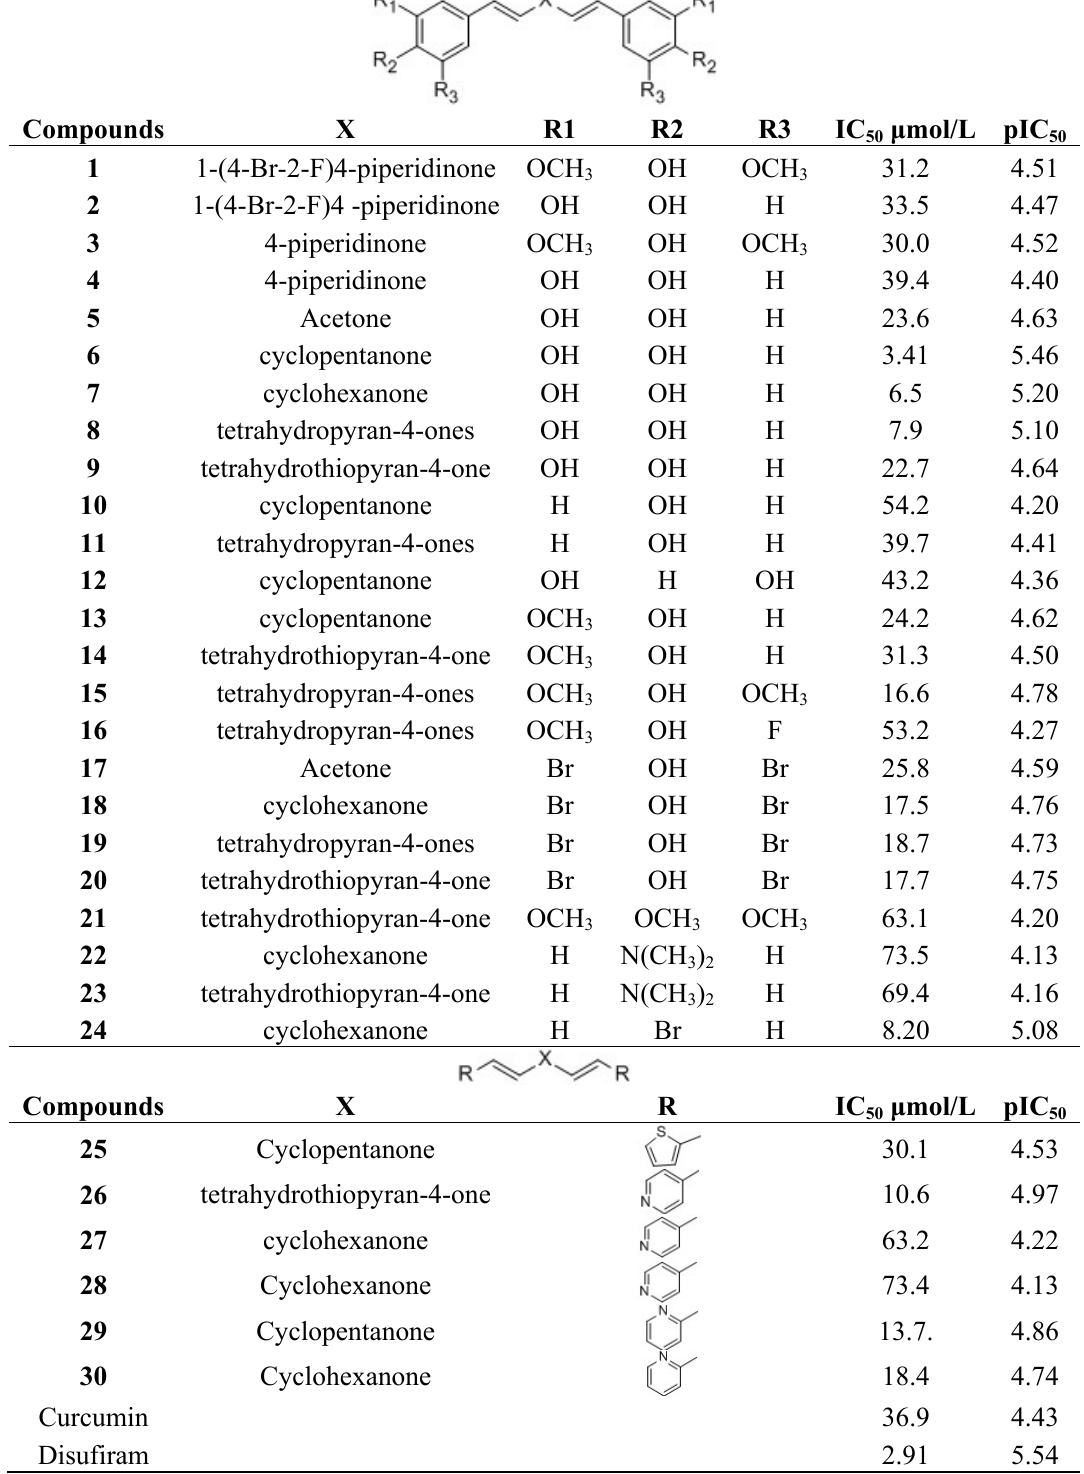
Table 1. The structures and bioactivity values of activity of curcumin